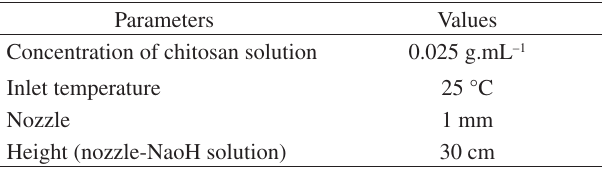
Table 2. Values of constant parameters used in the study.